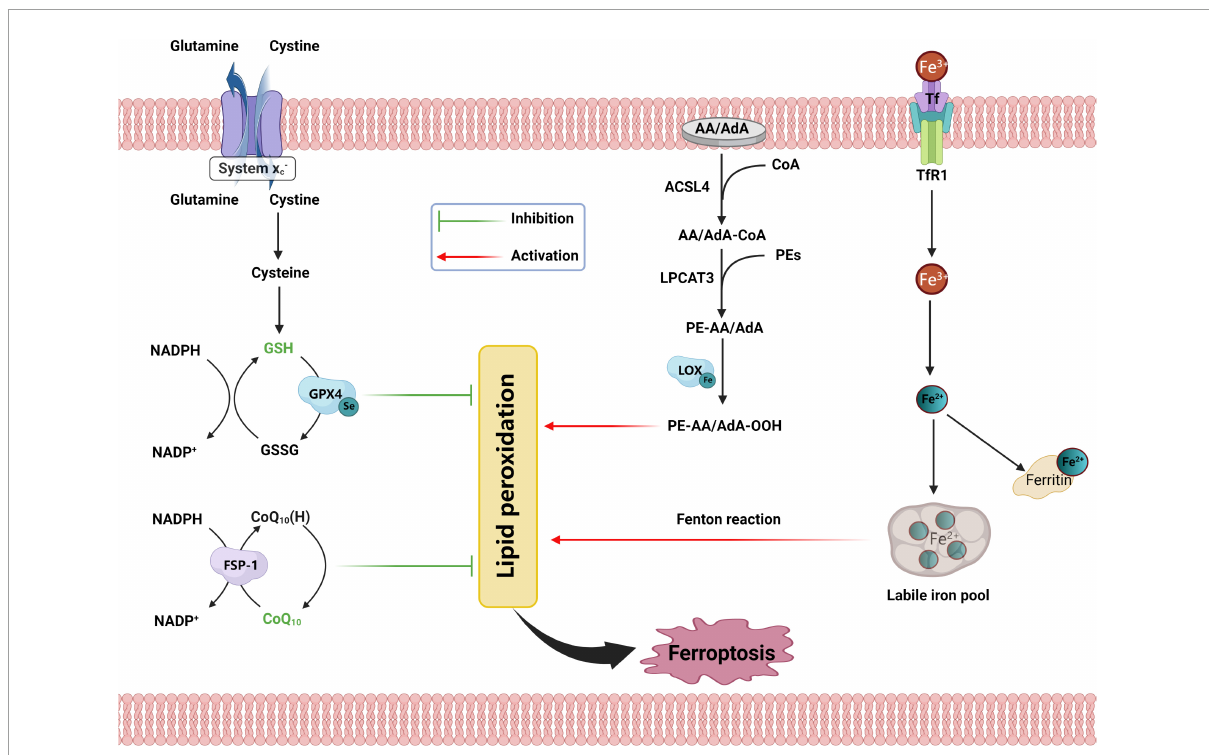
FIGURE1 Schematic representation for the mechanism of ferroptosis, including antioxidant systems, iron disorder, and lipid peroxidation. SLC7A11, solute carrier family 7 member 11; SLC3A2, solute carrier family 3 member 2; GSH, glutathione; GSSG, oxidized glutathione; GPX4, glutathione peroxidase 4; NADPH, nicotinamide adenine dinucleotide phosphate; GPX4, glutathione peroxidase 4; CoQ10, coenzyme Q10; FSP1, ferroptosis suppressor protein 1; AA, arachidonic acid; AdA, adrenic acid; CoA, coenzyme A; ACSL4, acyl-CoA synthetase long-chain family member 4; AA/AdA-CoA, adrenic acid/arachidonic acid-CoA; PEs, phosphatidylethanolamines; LPCAT3, lysophosphatidylcholine acyltransferase 3; PE-AA/AdA, phosphatidylethanolamine-adrenic acid/arachidonic acid; LOX, lipoxygenase; PE-AA/AdA-OOH, phosphatidylethanolamine- adrenic acid/arachidonic acid bis/trioxide; Tf, transferrin; TFR1, transferrin receptor